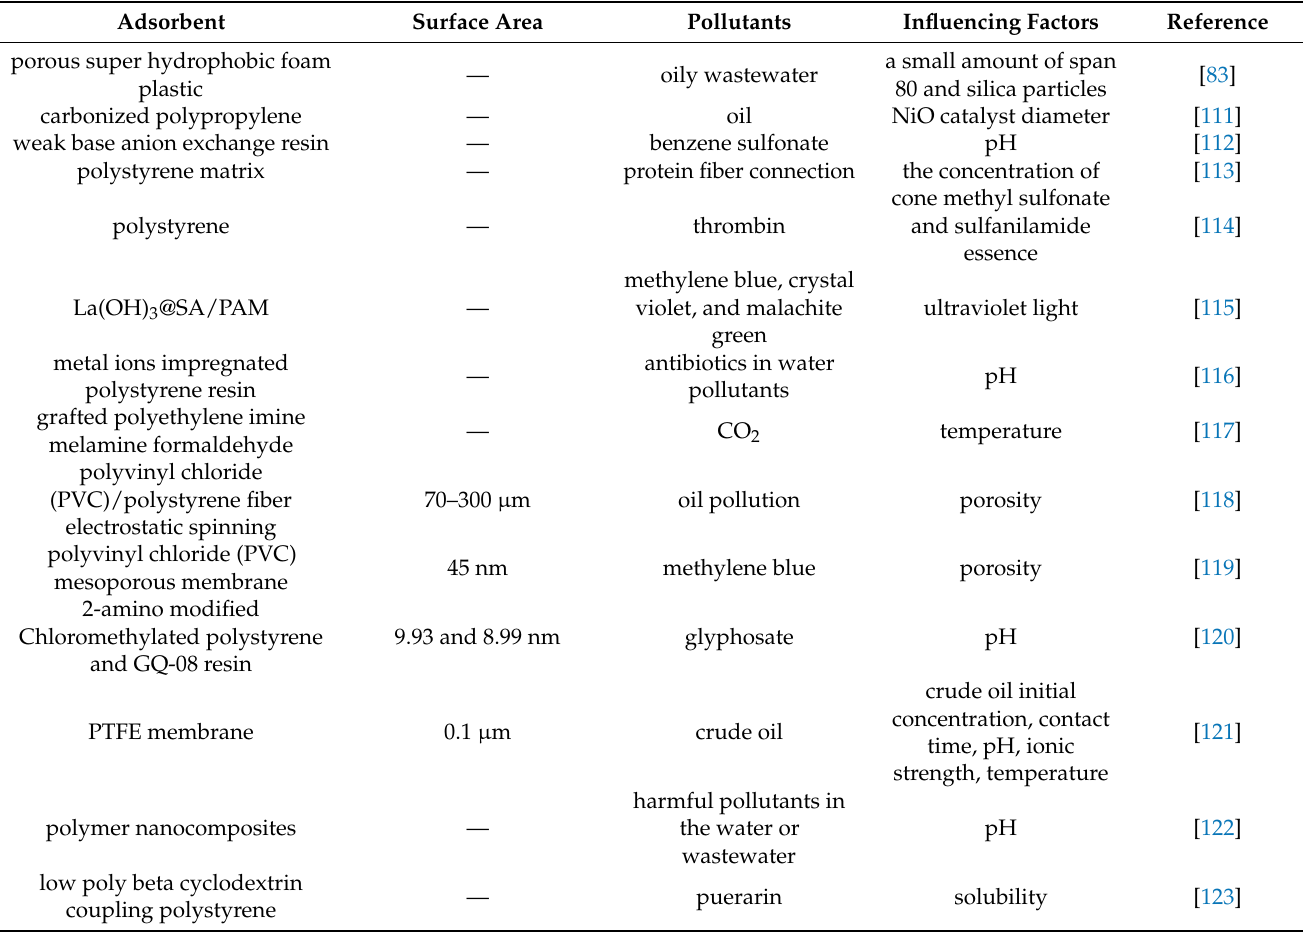
Table 3. Adsorption of mixed